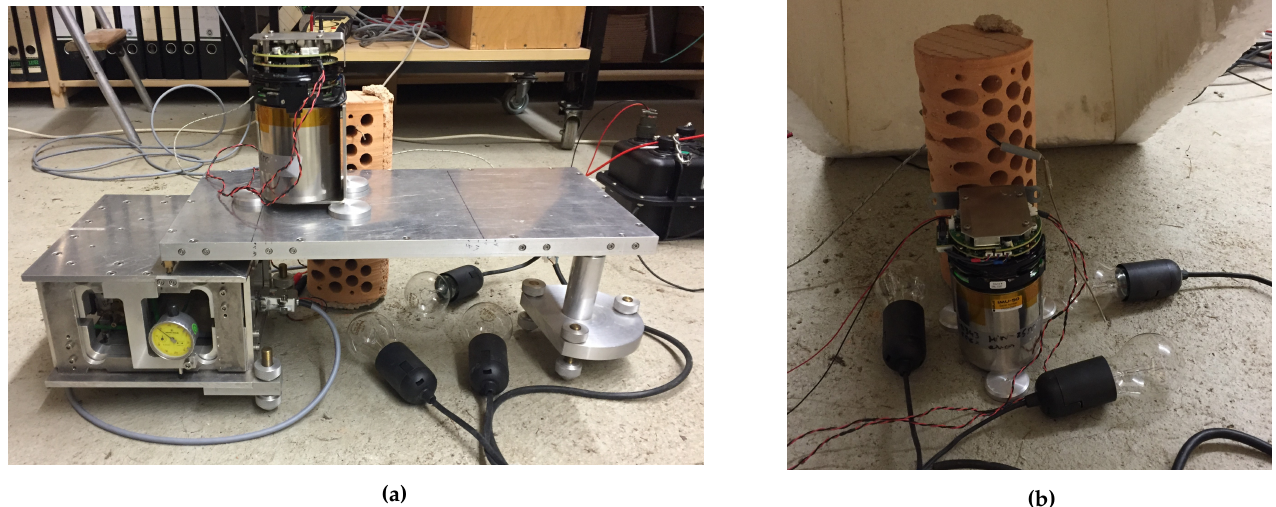
Figure 4. Setup of sensor number 0347 for testing ( a ) the effect of temperature on the scale factor of FOG component HJY and ( b ) the self-noise of the rotation